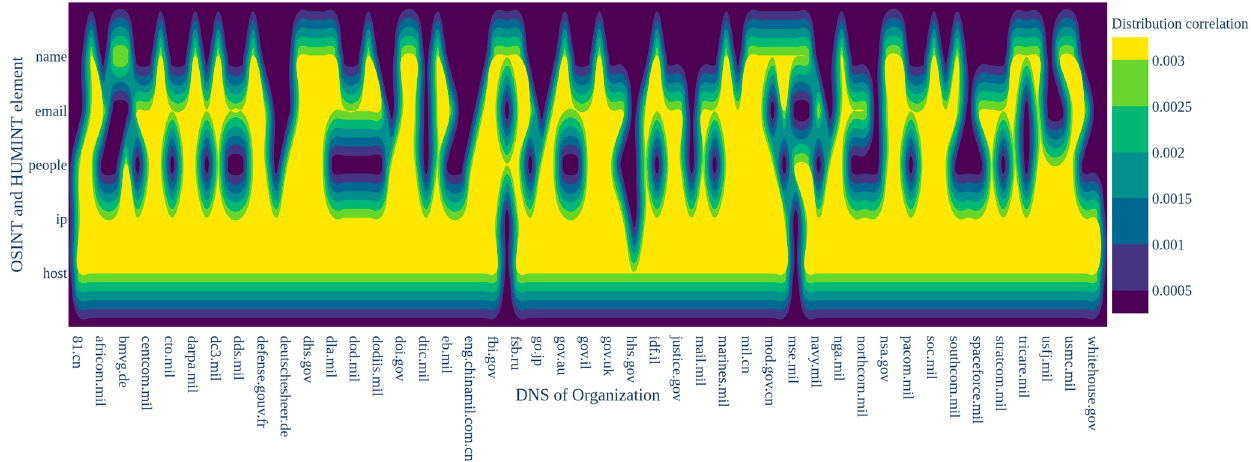
Figure A1. Relative entropy-based probability distribution correlation of organizational OSINT with Table A1.